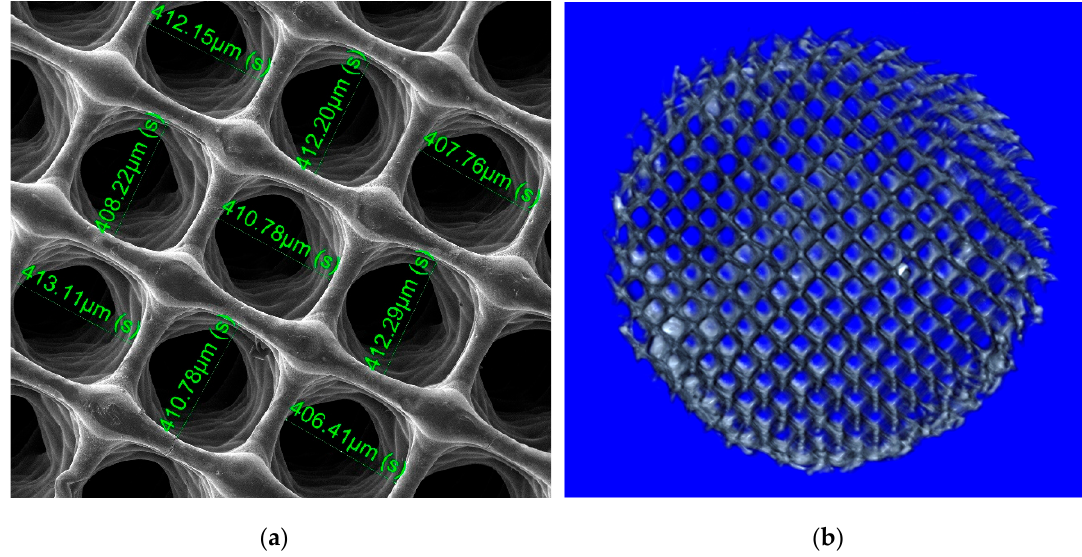
Figure 1. Determination of scaffold porosity. ( a ) SEM image taken to measure fiber diameter and pore size after the printing process. N = 3. Scale bar = 500 µm. ( b ) Non-cultured PCL scaffold three-dimensional reconstruction and sectioning to observe the different physical properties. n = 3. Scale bar = 1 mm.